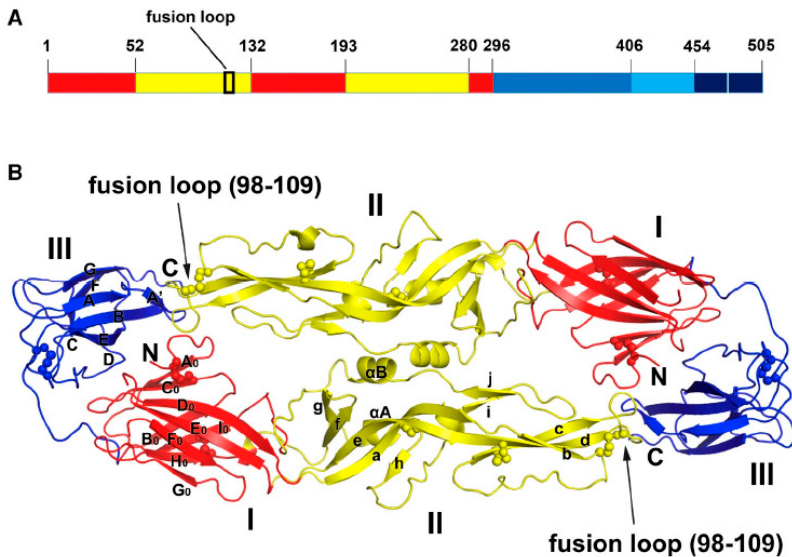
Figure 2. Structure of the E protein of ZIKV. ( A ) Domain organization of ZIKV E protein. Domain I, II and III are schematically indicated with red, yellow, and blue bars, respectively. ( B ) Dimer structure of the E protein of ZIKV. Domain I, II and III follow the same color scheme as Panel A and the position of fusion loop is indicated with an arrow. The locations of epitopes for various antibodies are indicated with spheres. (From [54] with permission from Elsevier).